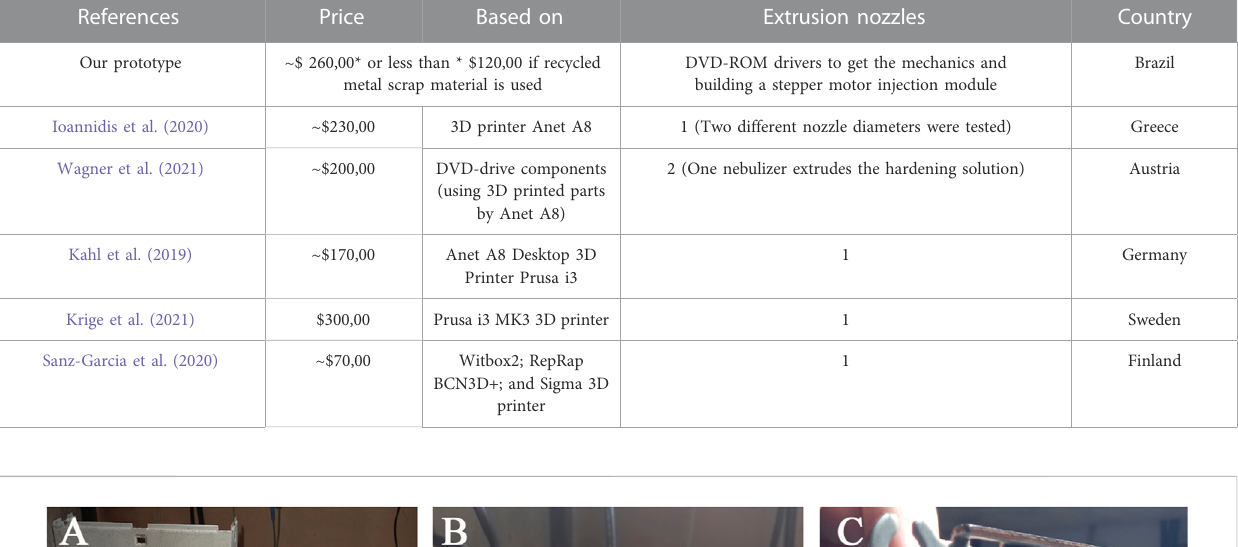
TABLE 1 Bioprinters built with low-cost parameters.